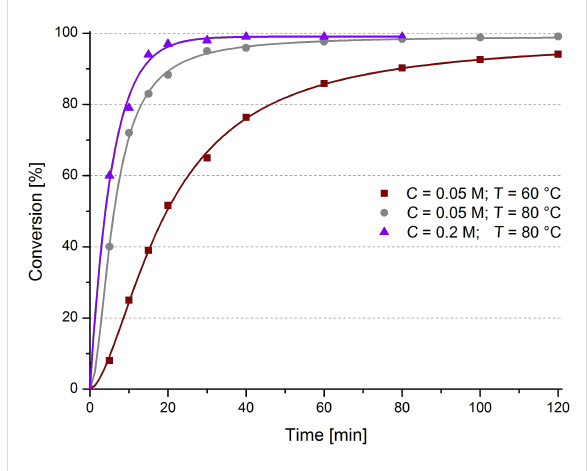
Figure 3: Influence of temperature and concentration on RCM of 9 . Conditions: 1 mol % of 8 -C* (5 wt % on C*), in